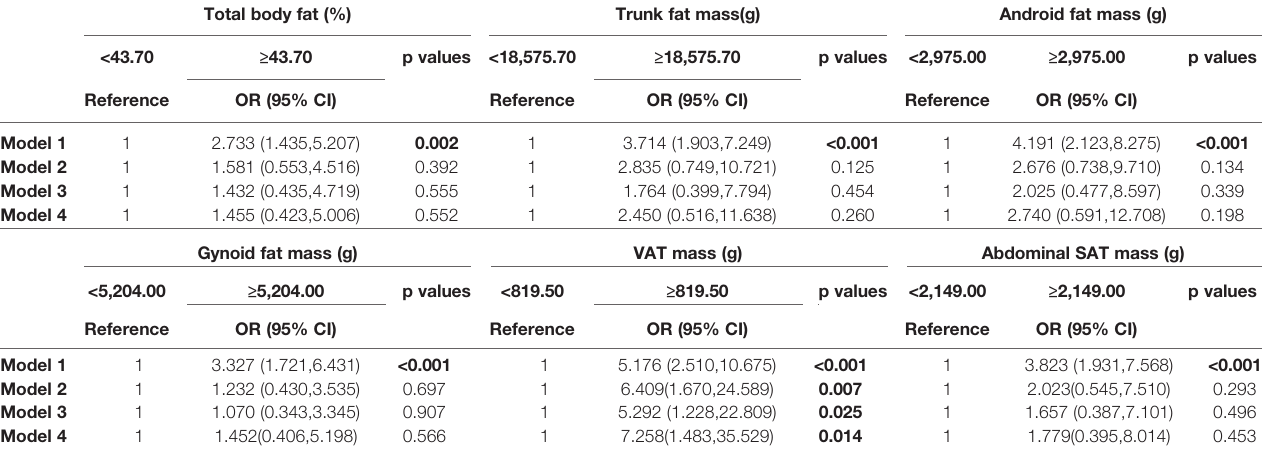
TABLE 4 | Logistic regression analysis of different degrees of body fat distribution characteristics and